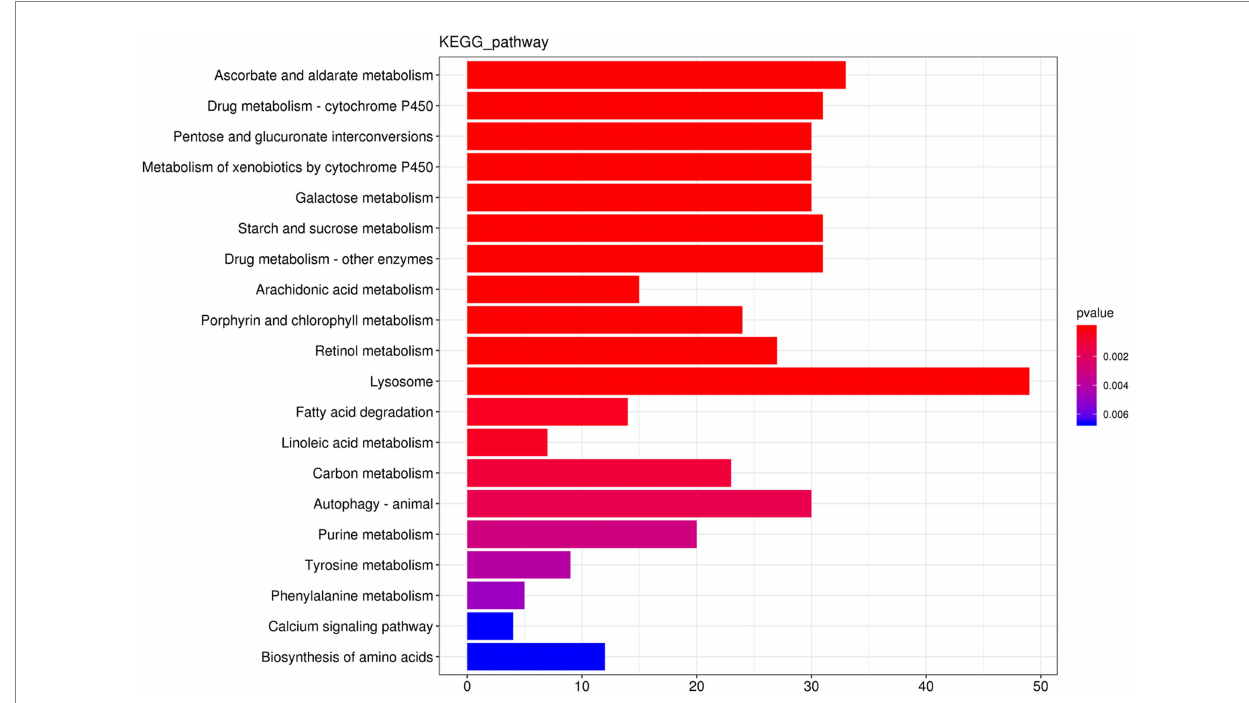
FIGURE 4 KEGG enrichment diagram. The horizontal coordinate is the gene number, the number of genes of interest annotated in the entry, and the vertical coordinate is each pathway entry. The color of the bars represents the value of p of the hypergeometric test.